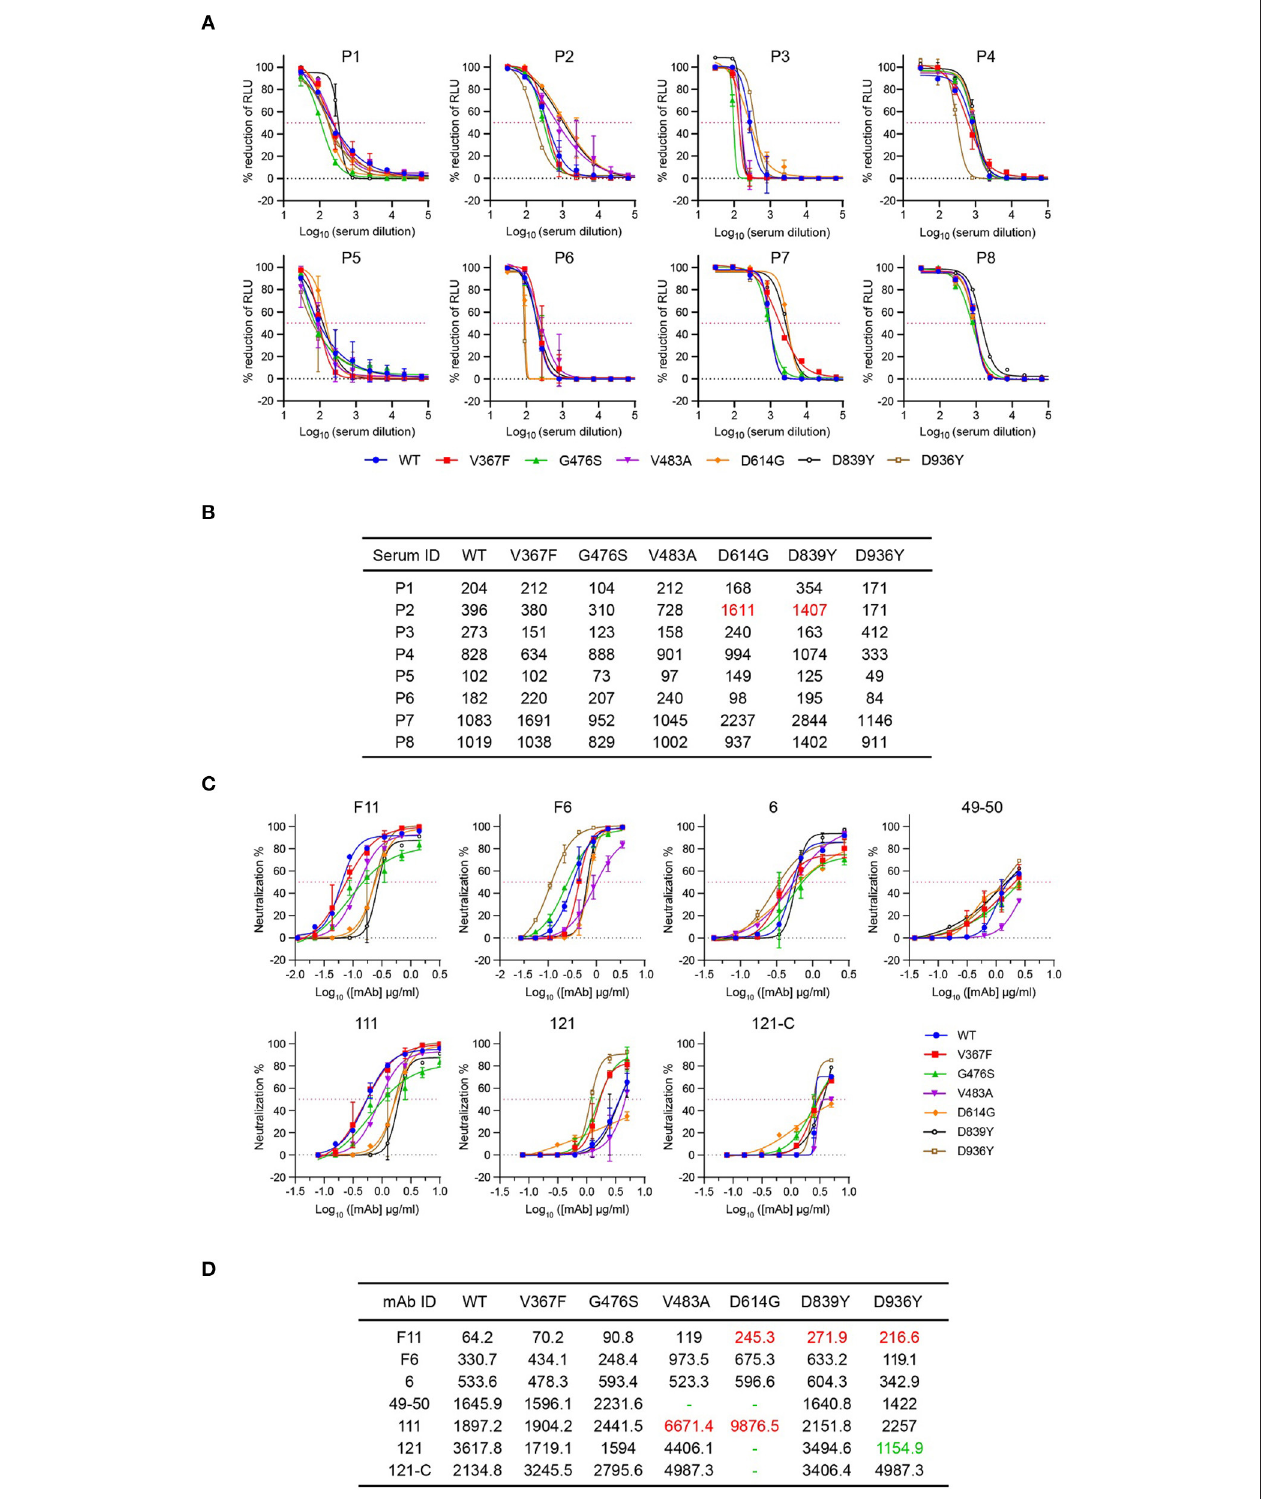
FIGURE 3 | Neutralization activity of sera from COVID-19 convalescence patients and mAbs targeting RBD against rVSV-S variants. (A) Eight sera samples were tested against rVSV-S WT and six variants using the focus reduction neutralization test. Error bars represent SD. All neutralization assays were performed in triplicate. (B) ID50 values of sera against rVSVs variants more than three-fold higher than those of WT are highlighted in red. (C) Seven mAbs were tested against rVSV-SWT